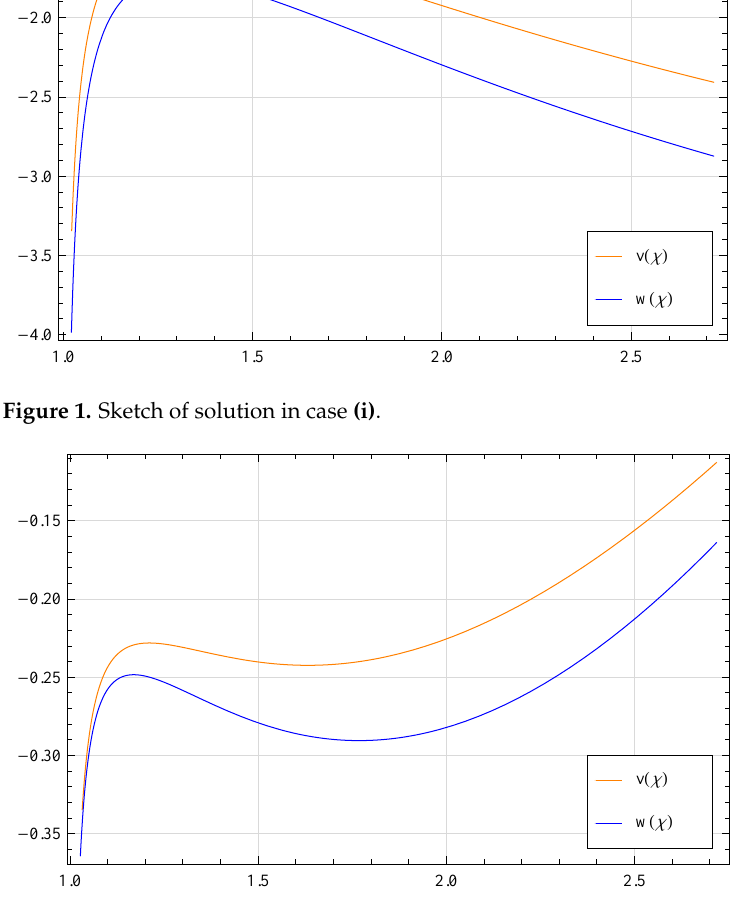
Figure 2. Sketch of solution in case (ii)